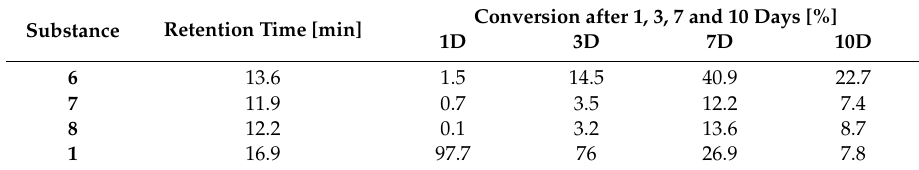
Table 2. Isaria fumosorosea KCh J2 transformation of 2 (cid:48) -methoxyflavone (glycosylated derivatives), UHPLC conversion.